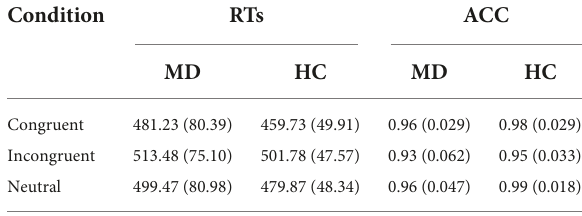
TABLE 2 Comparisons of RTs (ms) and ACC [mean (SD)] between the MD group and HC group.